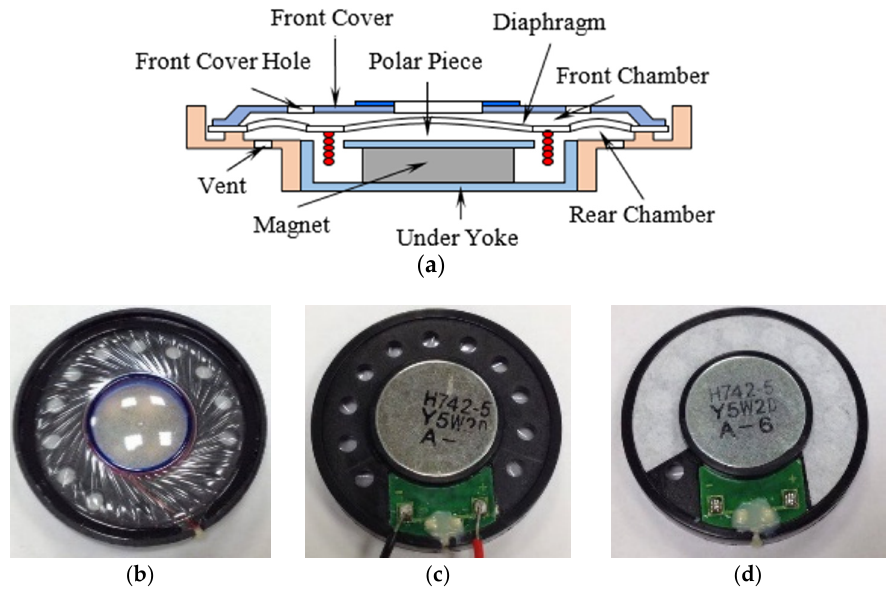
Figure 1. ( a ) Microspeaker schematic, ( b ) Front view of microspeaker, ( c ) Rear view (without ventilation cloth) of microspeaker, and ( d ) Rear view (with ventilation cloth) of microspeaker.